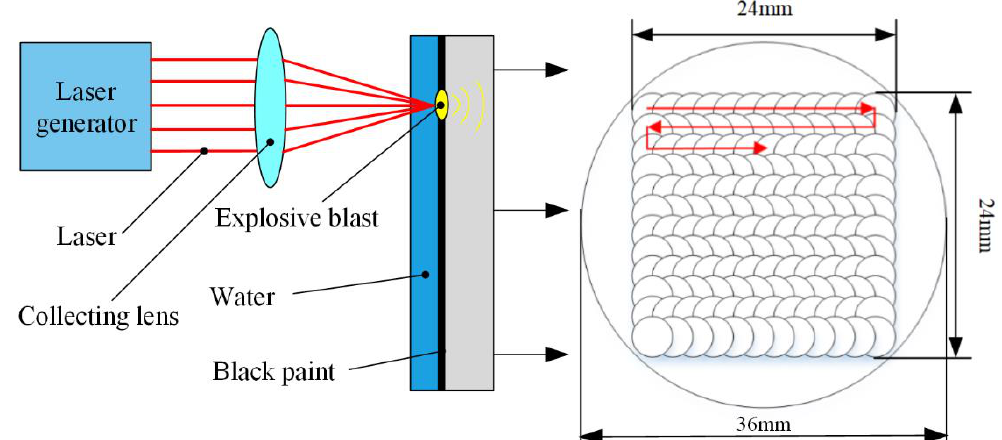
Figure 1. Schematic diagram of laser shock peening and the pattern of laser impact